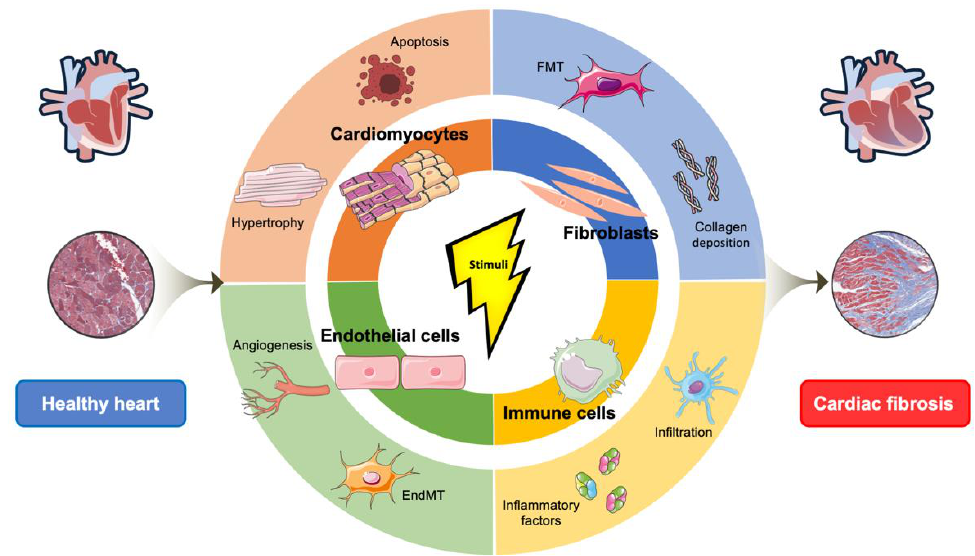
Figure 4. Illustration of cell-type resolved quantitative proteomic analysis of cardiac fibrosis.